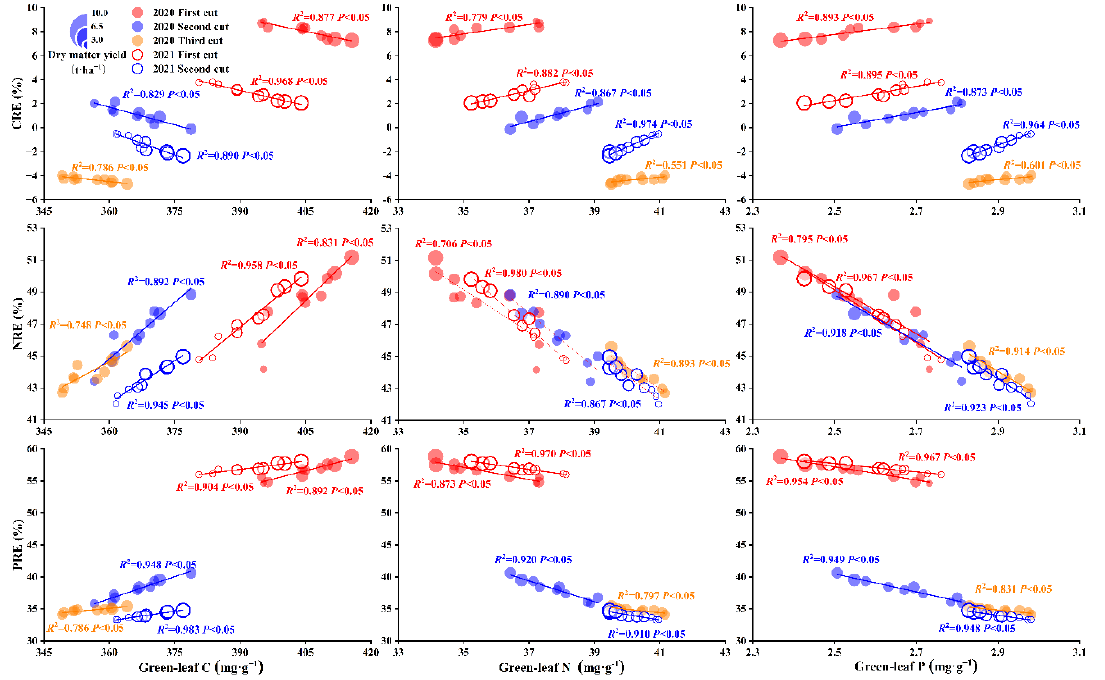
Figure 9. Relationship among C, N, and P, element reabsorption, and dry matter yield in mature